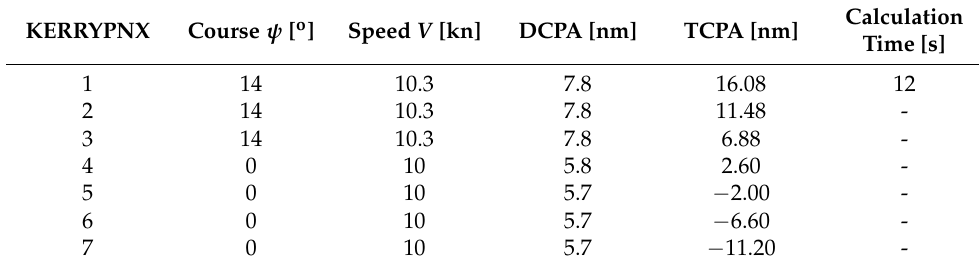
Table 2. Data on the trajectories of the ship—ACNN